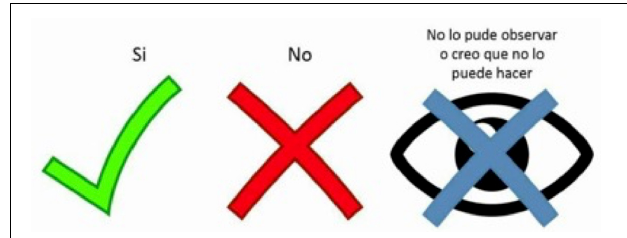
FIGURE 3 | Report icons of parent–child interaction in CARE